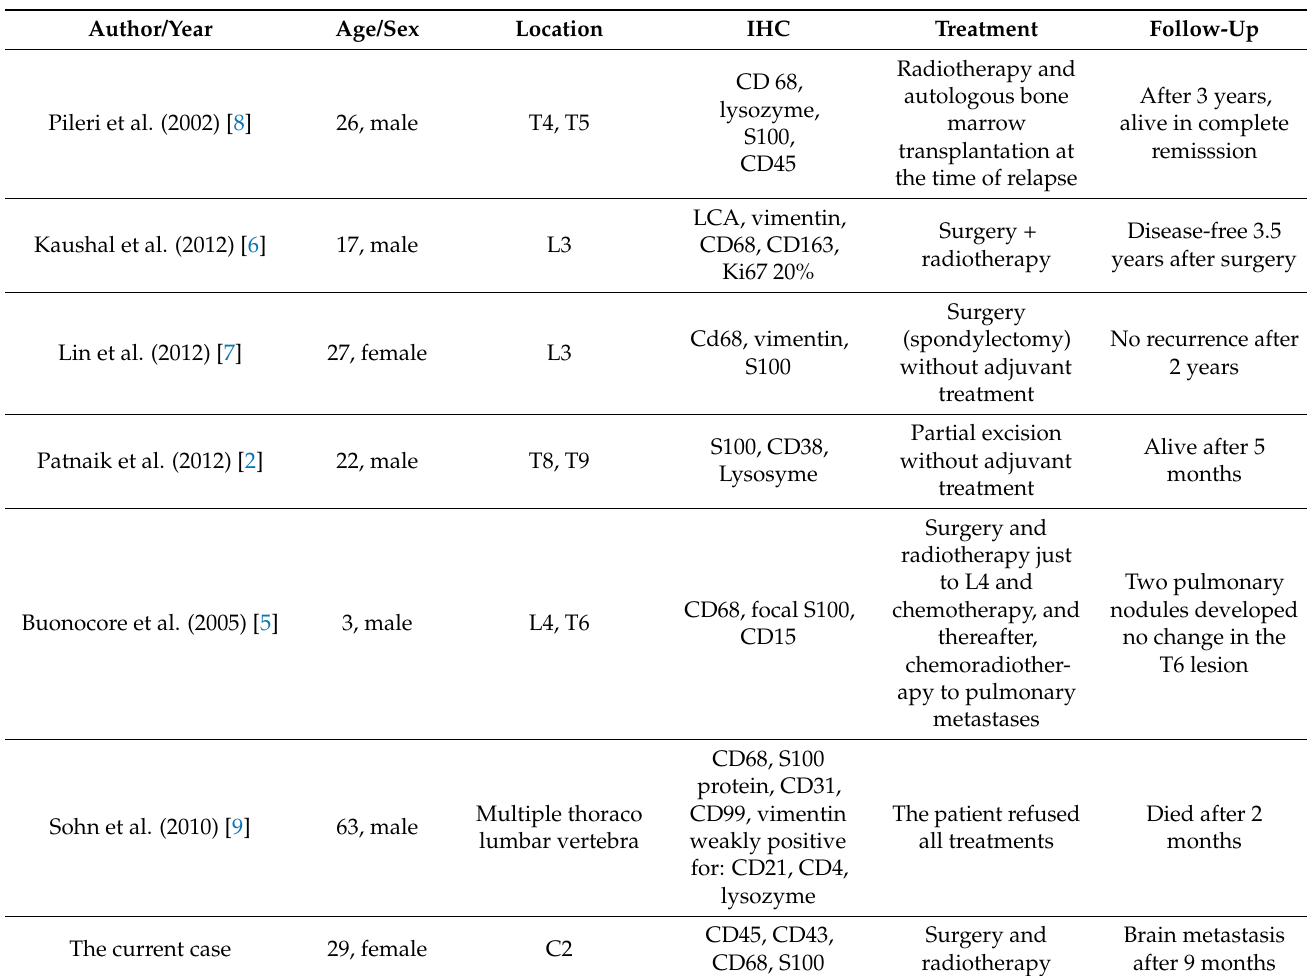
Table 1. Summary of the main cases published in the literature, with description of the site, histologi- cal characteristics, treatment and